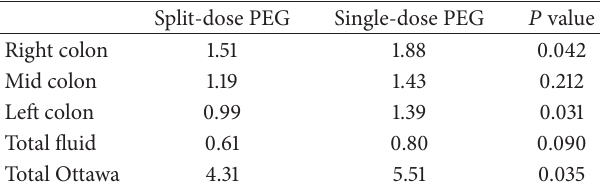
Table 2: Mean Ottawa scores parameters for morning procedures.